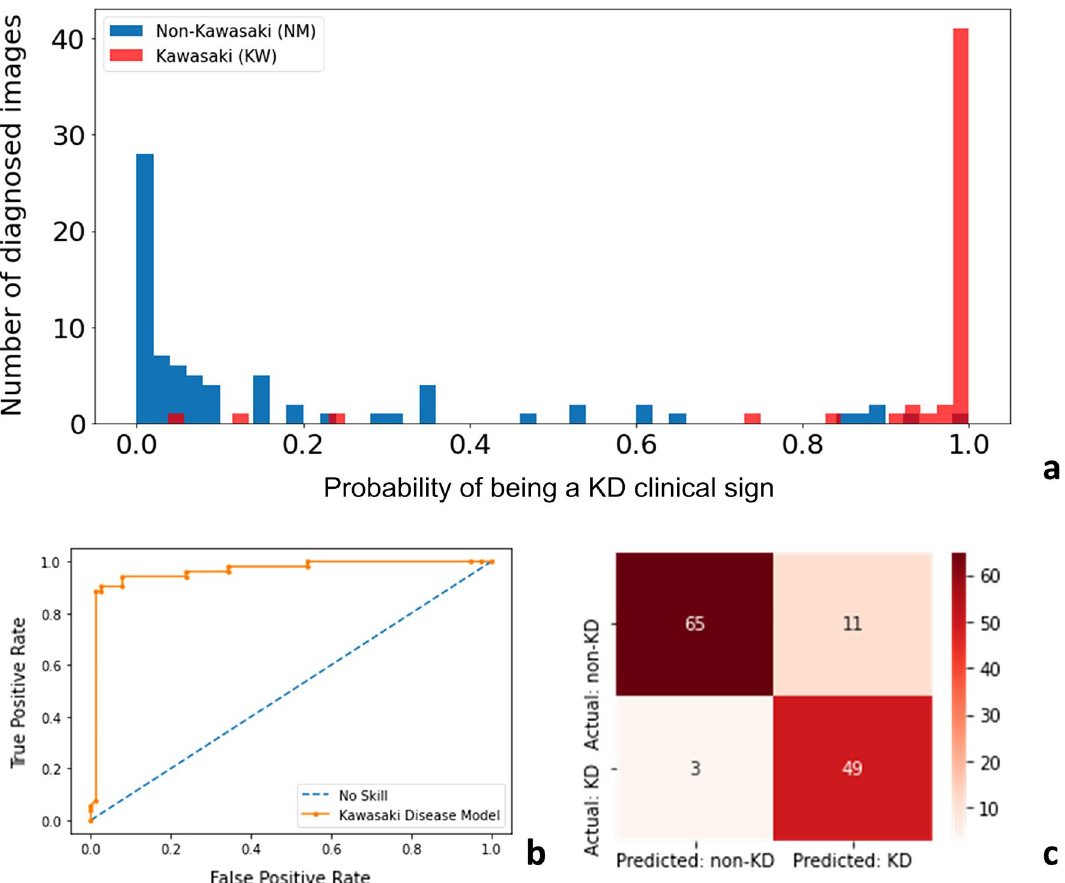
Figure 2. Examples of types of model evaluation used in each fold of cross validation: ( a ) true class probability chart, ( b ) area under the curve of receiver operating characteristic, ( c ) confusion matrix. Body Eyes Extremities